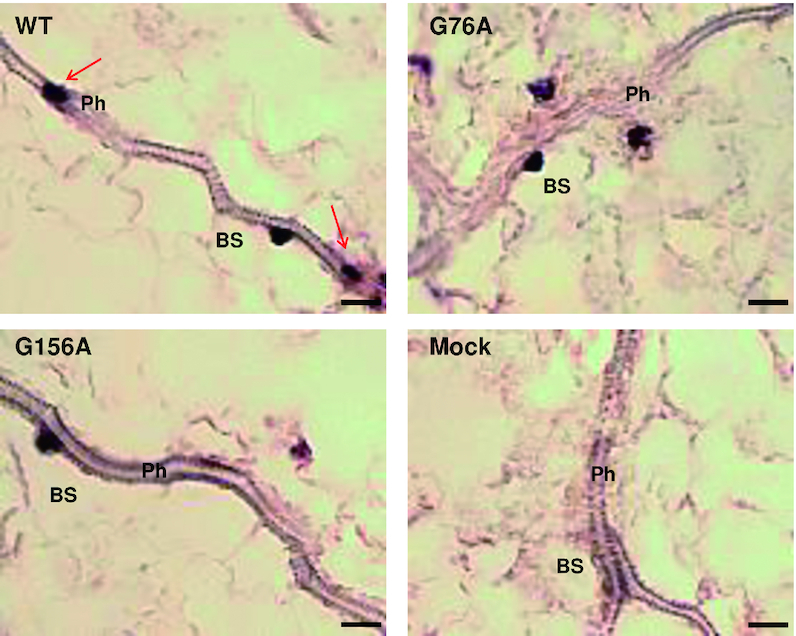
Mutants G76A and G156A fail to traffic into vascular tissue. In situ hybridization was carried out with paradermal sections obtained 12 dpi from mock inoculated leaves or leaves rub-inoculated with wild type PSTVd (WT), G76A or G156A. Purple dots are viroid hybridization signals. Note that WT PSTVd accumulates in bundle sheath (BS) and phloem cells (Ph) (red arrows), while the two mutants are found in bundle sheath cells but are absent from the phloem. Images shown are representative of more than 40 sections for each treatment. Bars = 10 μm.